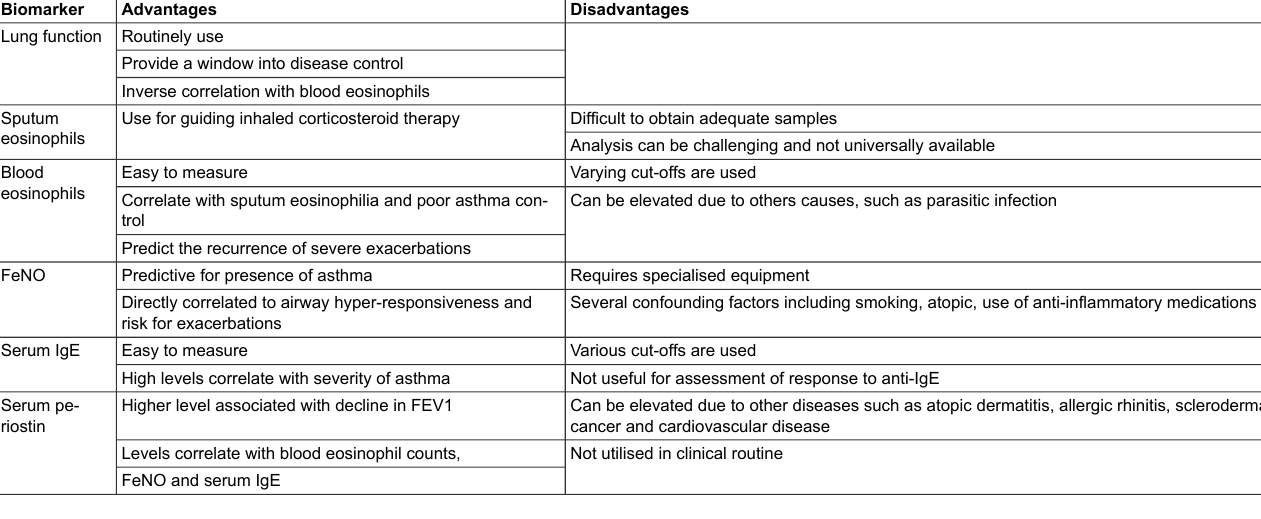
Table 1: Clinical features and type 2 inflammatory biomarkers (adapted from Medrek et al. [12]).